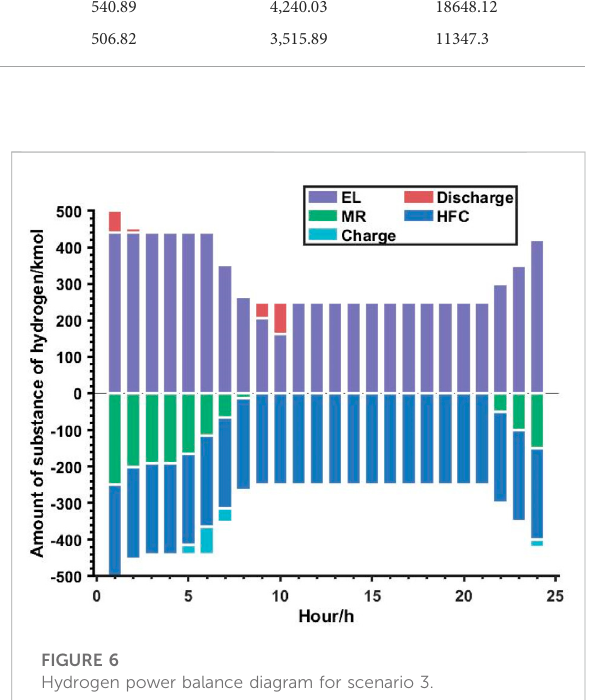
Figure 4. The installed capacity and operating parameters of each piece of equipment are shown in Table 1, and the actual carbon emission model parameters are shown in Table 2.